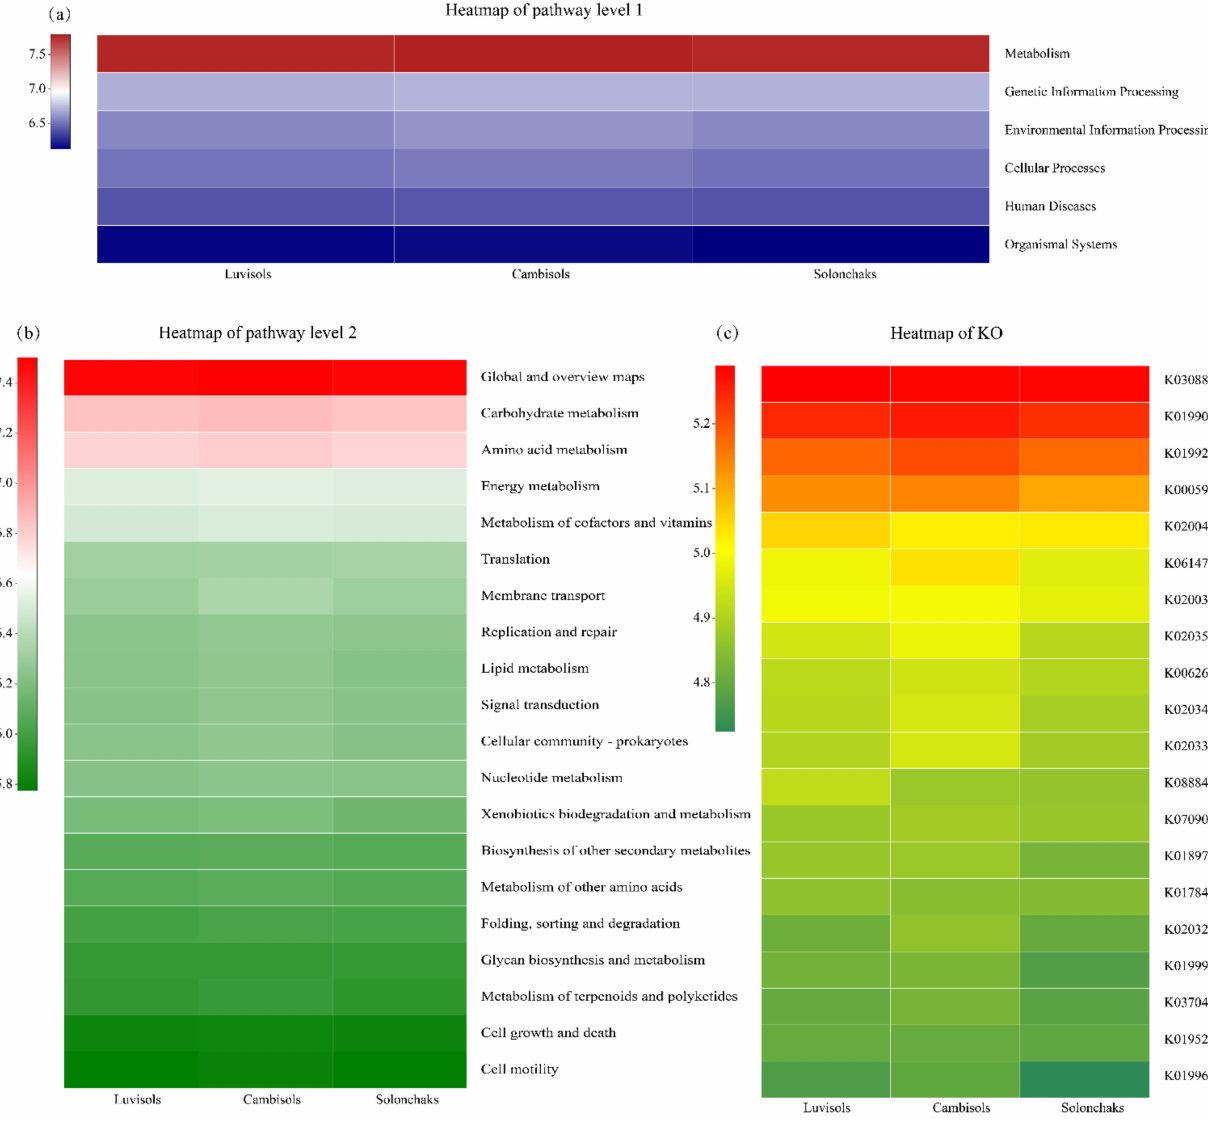
Figure 6. Prediction of rhizosphere bacterial function in different soil types of pecan plantations. The functional heatmaps show the top 20 functional types in abundance, and the color depth indicates the abundance